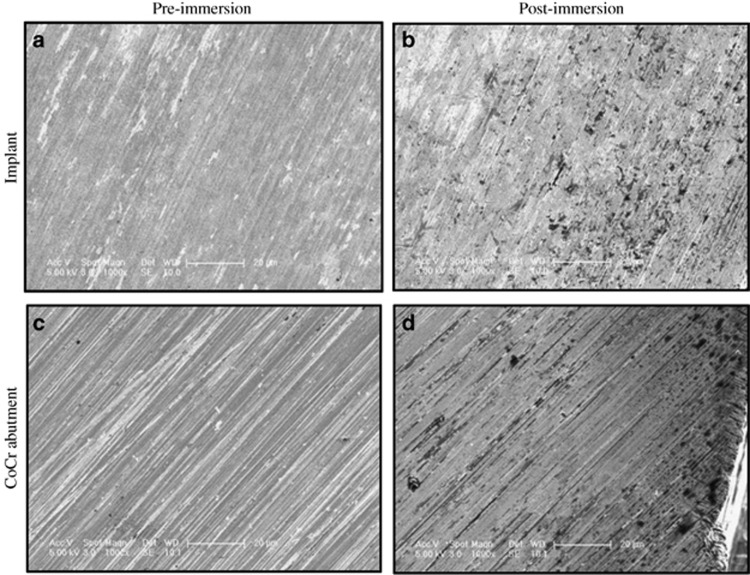
SEM images of the contacting surfaces of an implant and a CoCr abutment. Magnification x1 000. A titanium cylinder and a CoCr abutment from the CSW group before and after immersion for 1 week at 37 °C in 1% lactic acid solution. CoCr, cobalt–chrome; CSW, connected platform-switched cobalt–chrome abutment (5 mm); SEM, scanning electron microscopy.